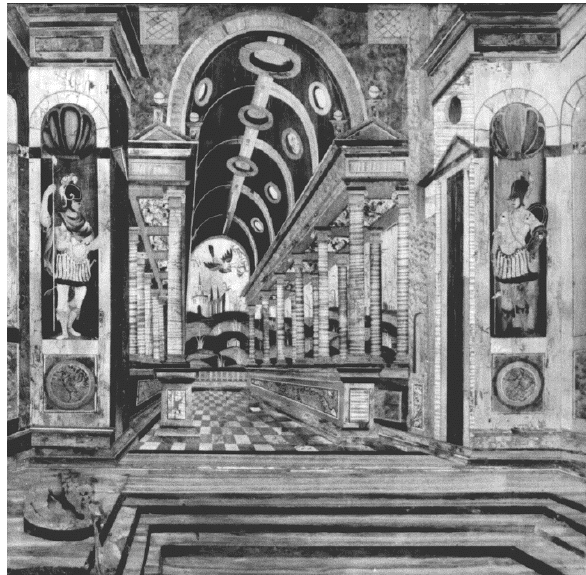
Figure 2. G.B. Vigilante, N. Ferraro, L. Ducha, T. De Vogel, wooden marquetry with architectural subject, Cerosa di